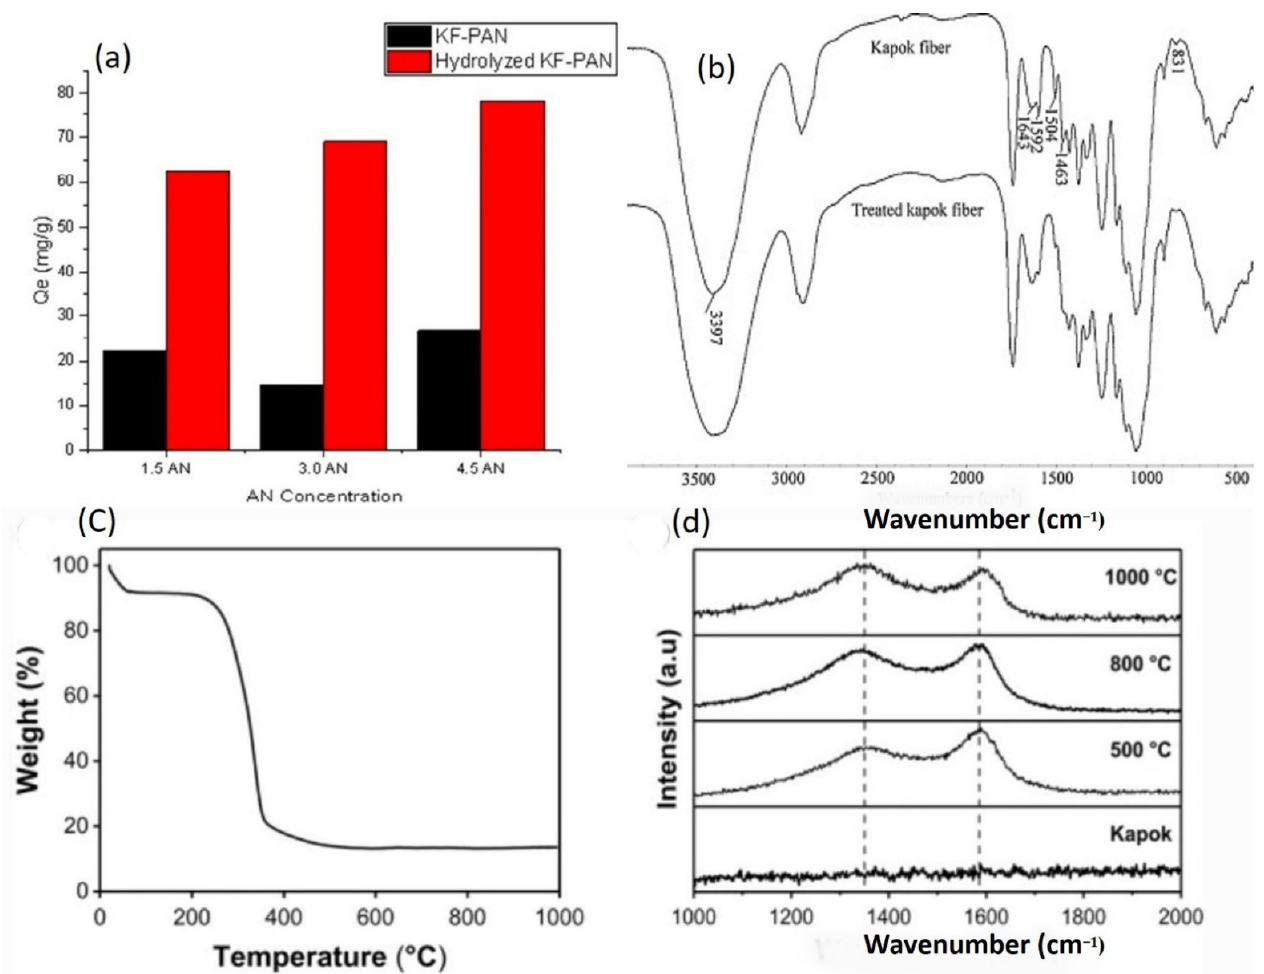
Figure 23. ( a ) Adsorption potential of Purified KF-PAN Nanocomposites made of KF-PAN at 200 mg/L Pb(II) for 24 h utilizing 30 mg of adsorbent. Reprinted with permission from Ref. [168]. Copyright 2019, copyright Elsevier; ( b ) Kapok fiber FTIR analysis prior/post NaClO 2 application. Reprinted with permission from Ref. [80]. Copyright 2012, copyright Elsevier; ( c ) The kapok TGA curve. ( d ) The Raman wavelengths of kapok and carbon microtubes that carbonized at temperatures of 500 °C, 800 °C, and 1000 °C, correspondingly. Reprinted with permission from Ref. [178]. Copyright 2019, copyright Springer Nature.